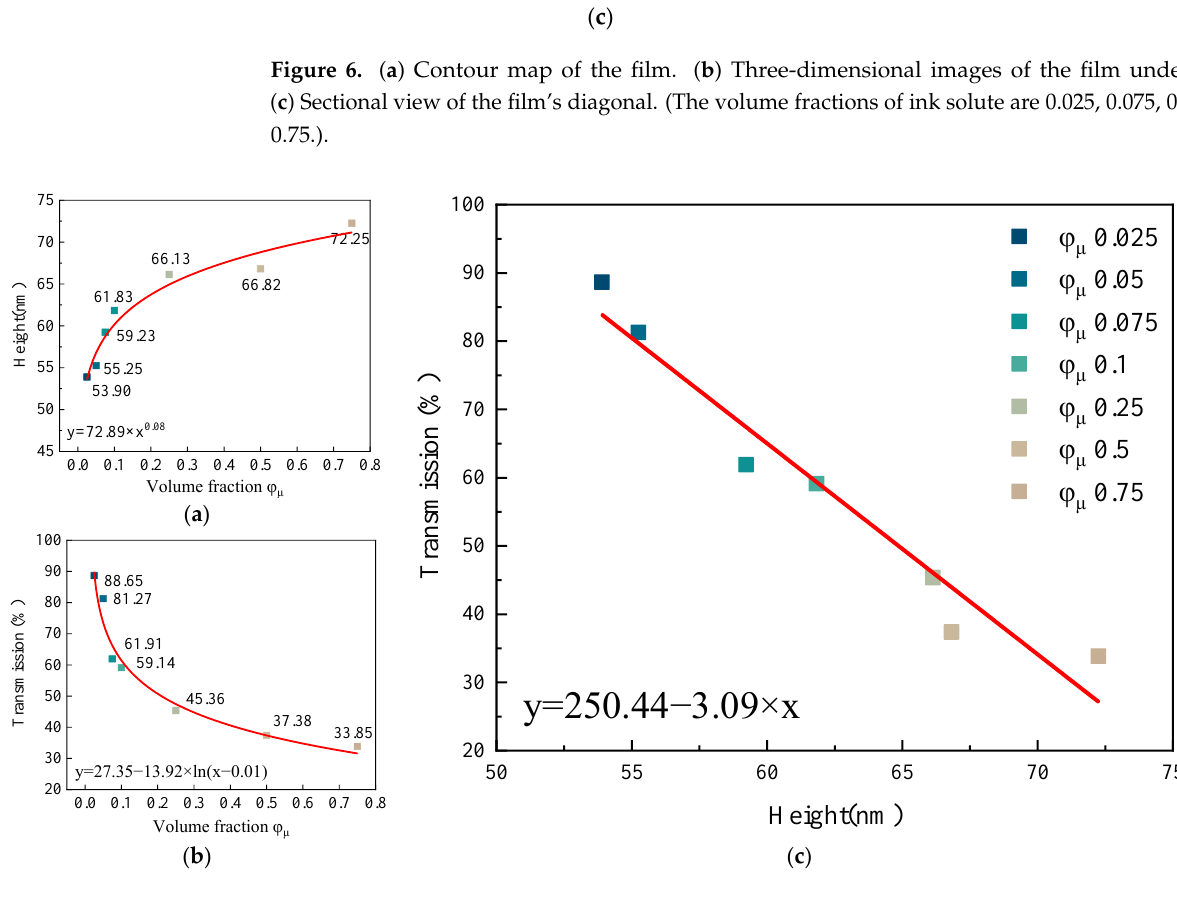
Figure 6. ( a ) Contour map of the film. ( b ) Three-dimensional images of the film under AFM. ( c ) Sectional view of the film ’ s diagonal. (The volume fractions of ink solute are 0.025, 0.075, 0.25, and 0.75.)